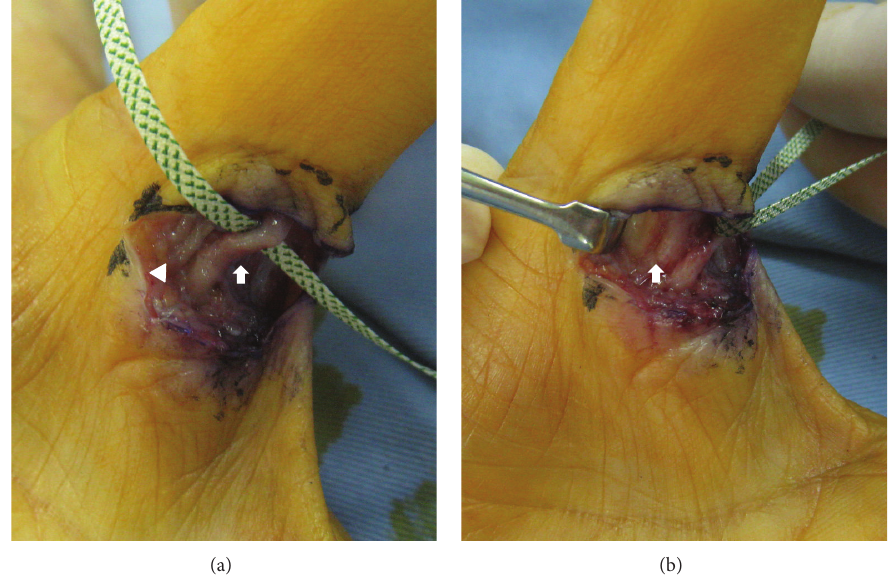
Figure 1: Intraoperative photograph of second surgery. The ulnar (arrow) and radial (arrowhead) neurovascular tissues were located over the tendon and near to the center of it. The ulnar digital nerve showed swelling like a neuroma (a). The flexor pollicis longus tendon was covered by scar tissue (arrow)